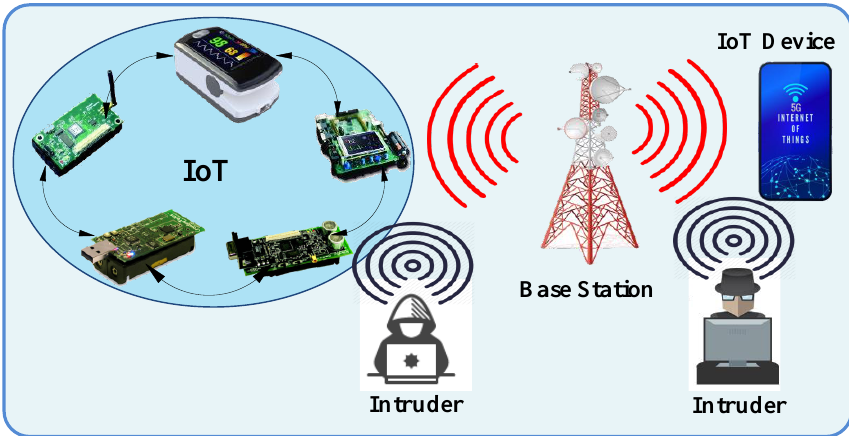
Figure 5. Structure diagram of possible cyberattacks in IoT.